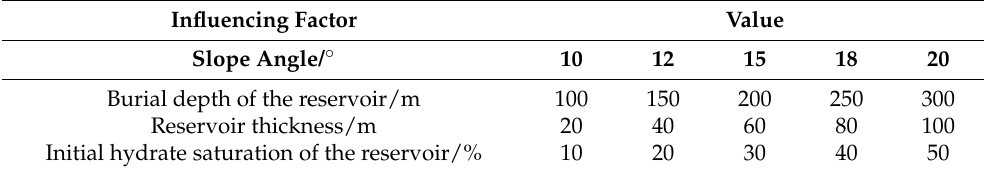
Table 1. Analytical factors and values.